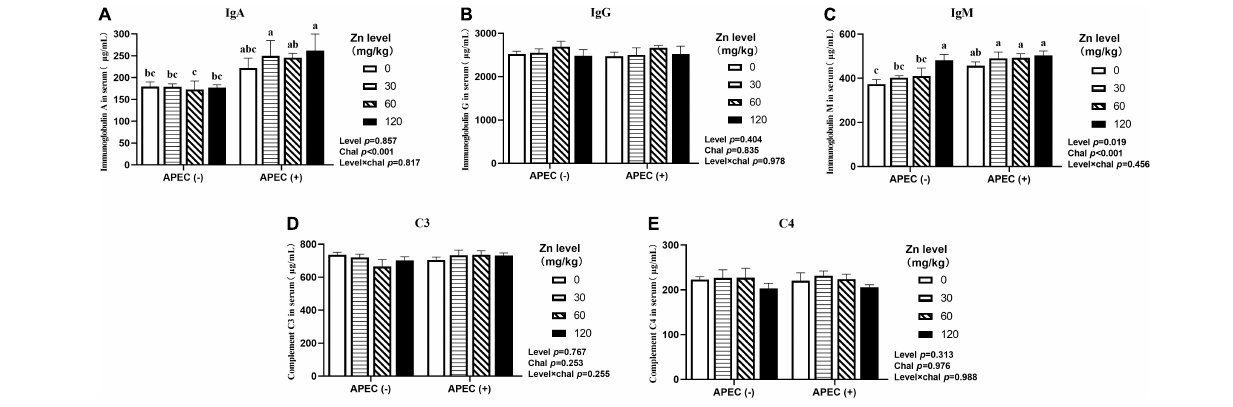
at 2 DPI and ZO-1 , ZO-2 , ZO-3 mRNA expression at 8 DPI in jejunum ( p < 0.05). At the same time, the jejunal mRNA expression of sIgA and AvBD2 were upregulated after APEC challenge ( p < 0.05). Ducks fed Zn–Met at 120-mg/kg diet had a higher ZO-3, OCLN mRNA expression at 2 DPI and ZO-2, ZO-3 mRNA expression at 8 DPI compared to those fed diets without Zn–Met supplementation ( p < 0.05). In addition, a dietary Zn–Met supplementation tended to upregulated CLDN2 mRNA expression at 2 DPI ( p = 0.065). The interactions between Zn–Met and APEC challenge had no influence on the mRNA expression of barrier-related gene in jejunum ( p >